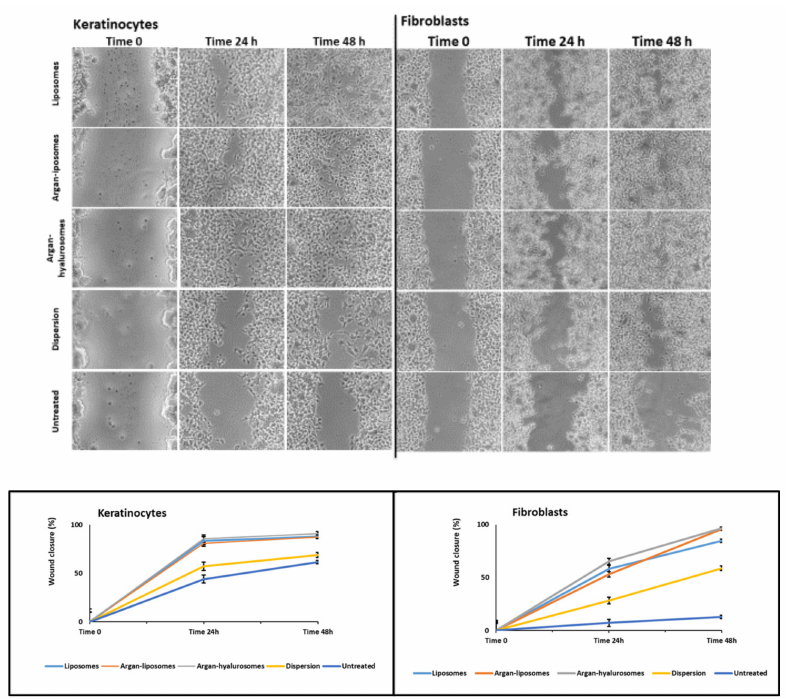
Figure 9. Representative images of scratch and percentage of wound closure in keratinocytes and fibroblasts, untreated or treated with neem oil in dispersion or loaded in liposomes, argan-liposomes and